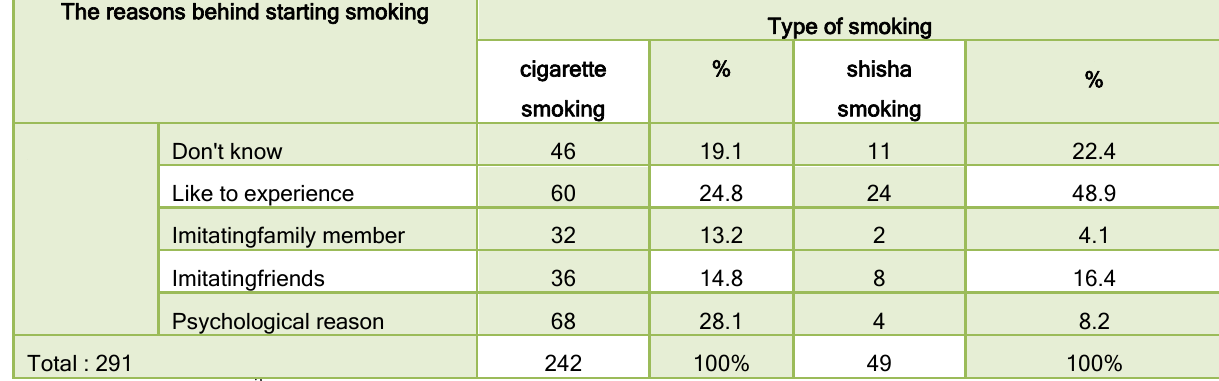
Table (4): Distribution of study sample according to reasons behind starting smoking. The reasons behind starting